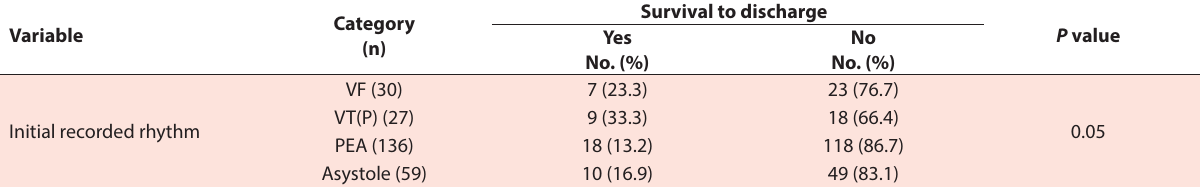
Table 2. Initial documented rhythm and survival-to-discharge rate among the study participants (n = 252) Variable